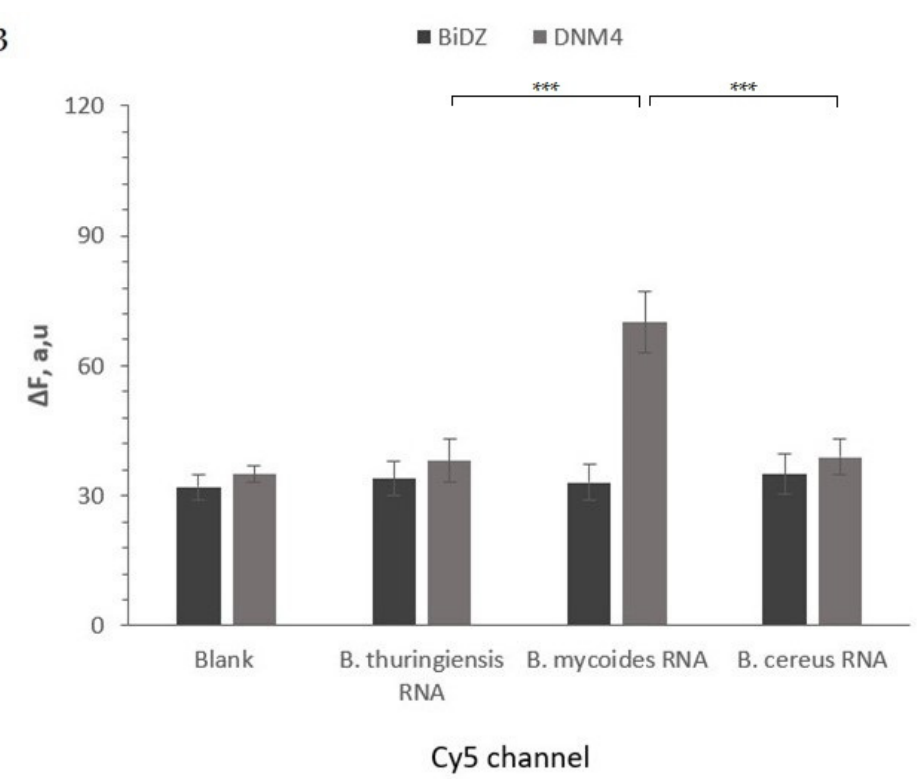
Figure 5. Analysis of the total bacterial RNA using BiDz and DNM4. ( A ) Fluorescence intensities of B. thuringiensis –specific BiDz (dark gray bars) and DNM4 (light gray bars) in the absence or the presence of 2 ng of B. thuringiensis RNA, B. mycoides RNA, and B. cereus RNA after 1 h of incubation at 55 ◦ C in the FAM channel. ( B ) Fluorescence intensities of B. mycoides –specific BiDz (dark gray bars) and DNM4 (light gray bars) in the absence or the presence of 2 ng of B. thuringiensis RNA, B. mycoides RNA, and B. cereus RNA after 1 h of incubation at 55 ◦ C in the Cy5 channel. Average values of three independent measurements are presented with one standard deviation. ***: p value < 0.001. Tables S6 and S7 contain data correspond to Figures 5A and 5B,